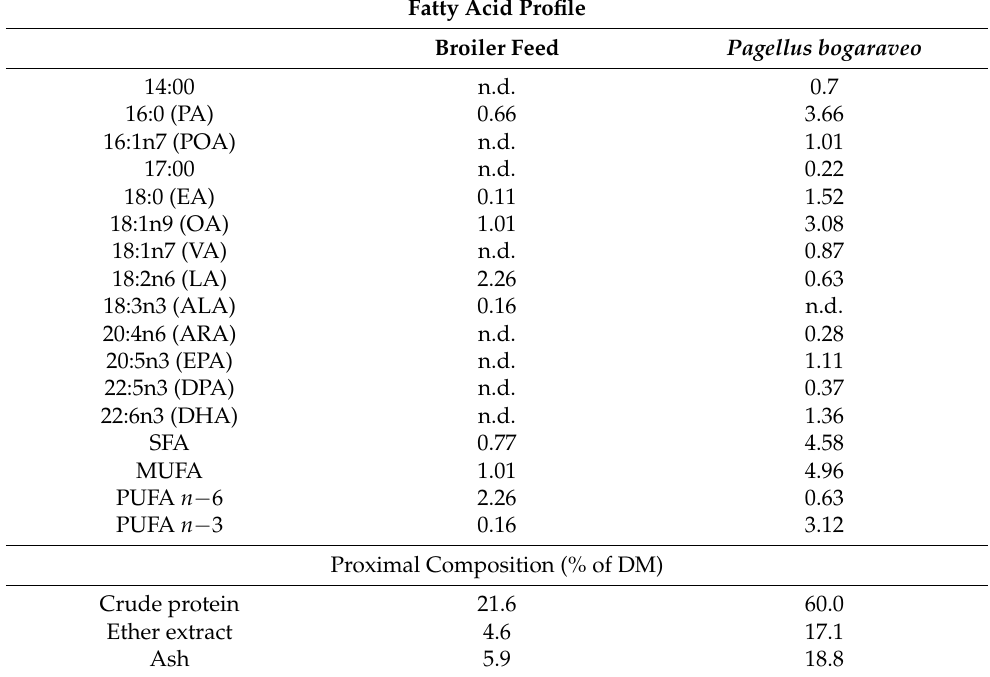
Table 1. Fatty acid profile (% of Fas of total Fas) and proximal composition of matter used in diets (dry matter,